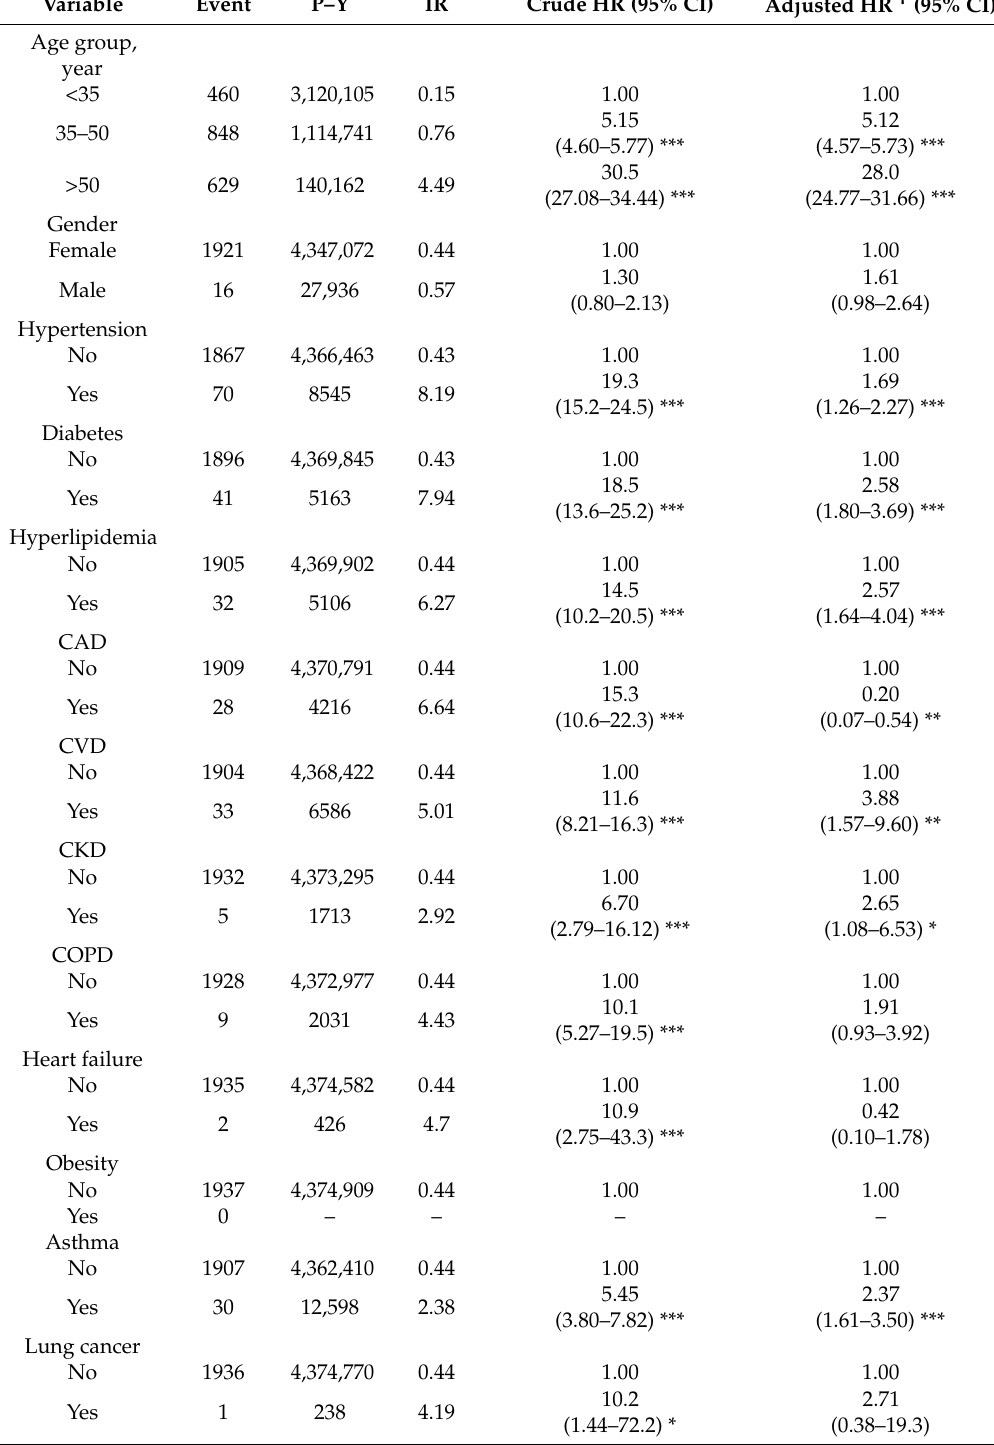
Table 2. Incidence rate and hazard ratio for ischemic stroke, stratified with age, sex, and comorbidities.